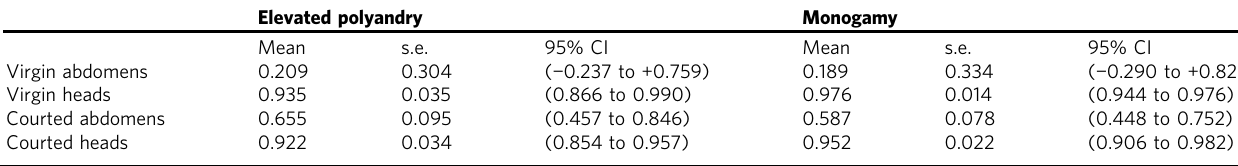
Table 3 Correlation analysis of gene expression changes between the sexes, with bootstrapped 95% con fi dence intervals